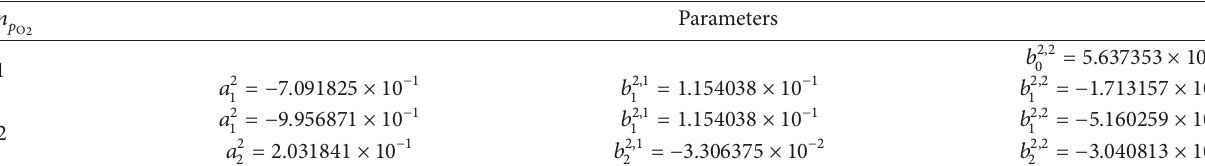
calculated by the second algorithm. O 2